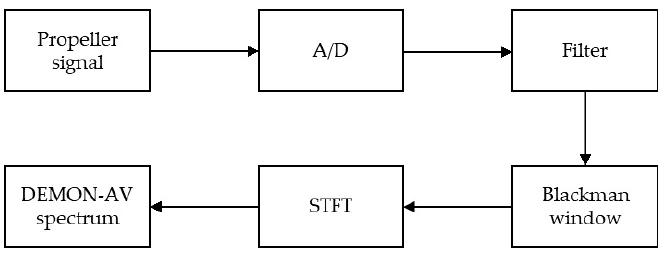
Figure 2. The proposed DEMON-amplitude variation